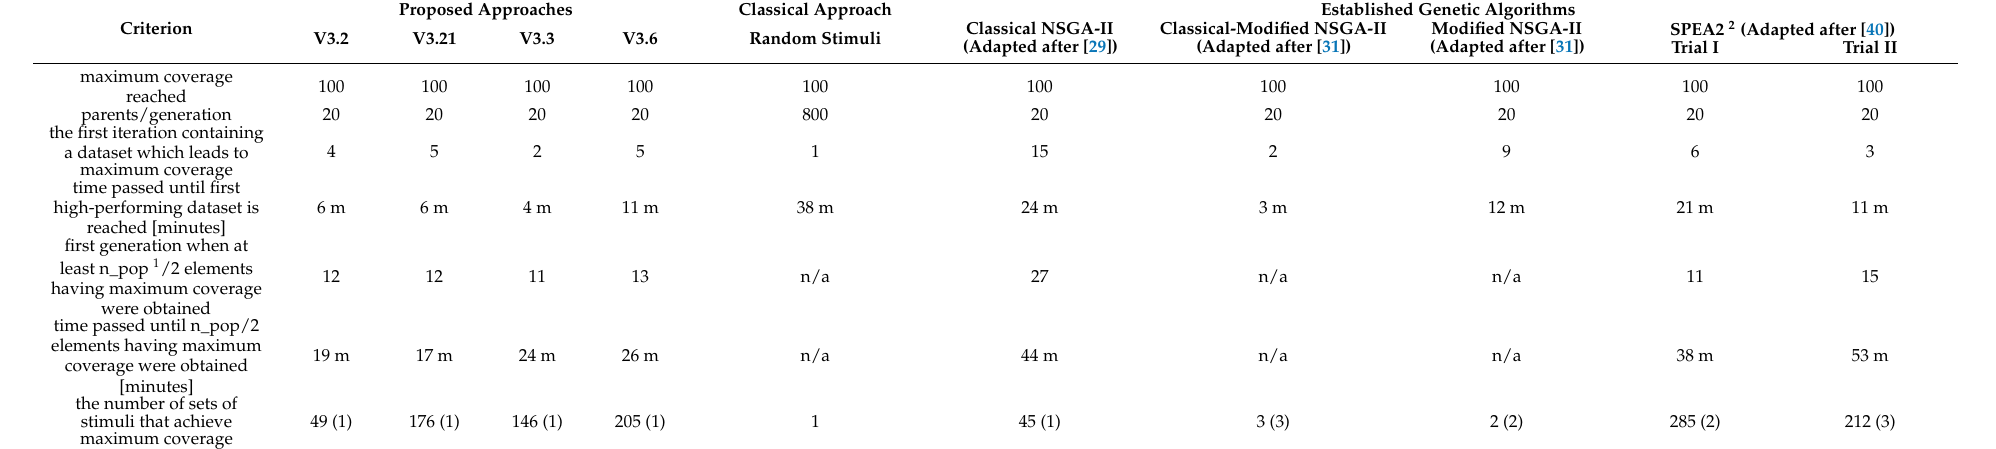
Table 2. Tabular comparison between genetic algorithm-based approaches and a sequence of 800 randomly generated stimulus sets for the main coverage